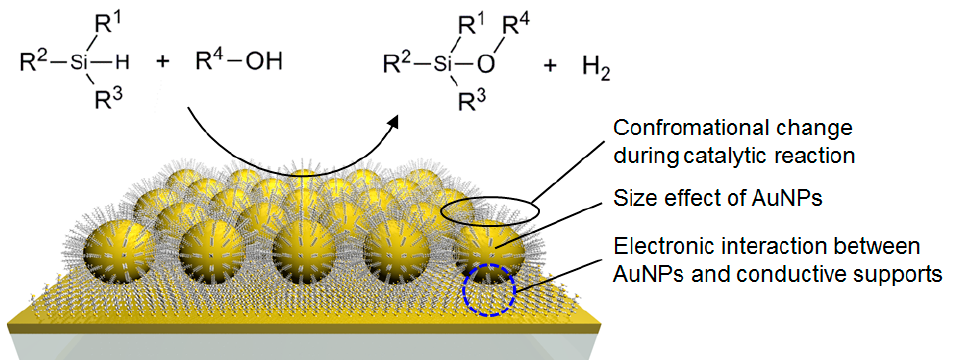
Figure 1. Schematic structure of the alkanethiolate self-assembled monolayer (SAM)-functionalized gold nanoparticle (AuNP) catalysts supported on conductive films for a silane alcoholysis reaction.